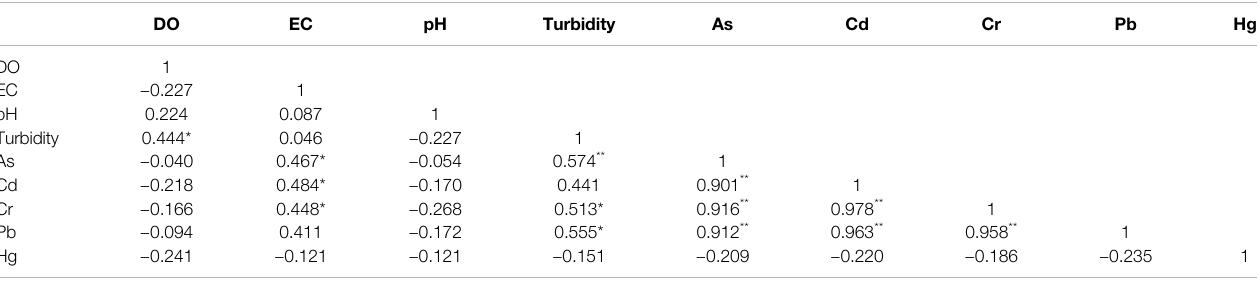
TABLE 5 | Correlation between heavy metals, DO, EC, pH, and Turbidity in sediment ( n (cid:2) 20). DO EC pH Turbidity As Cd Cr Pb Hg DO 1